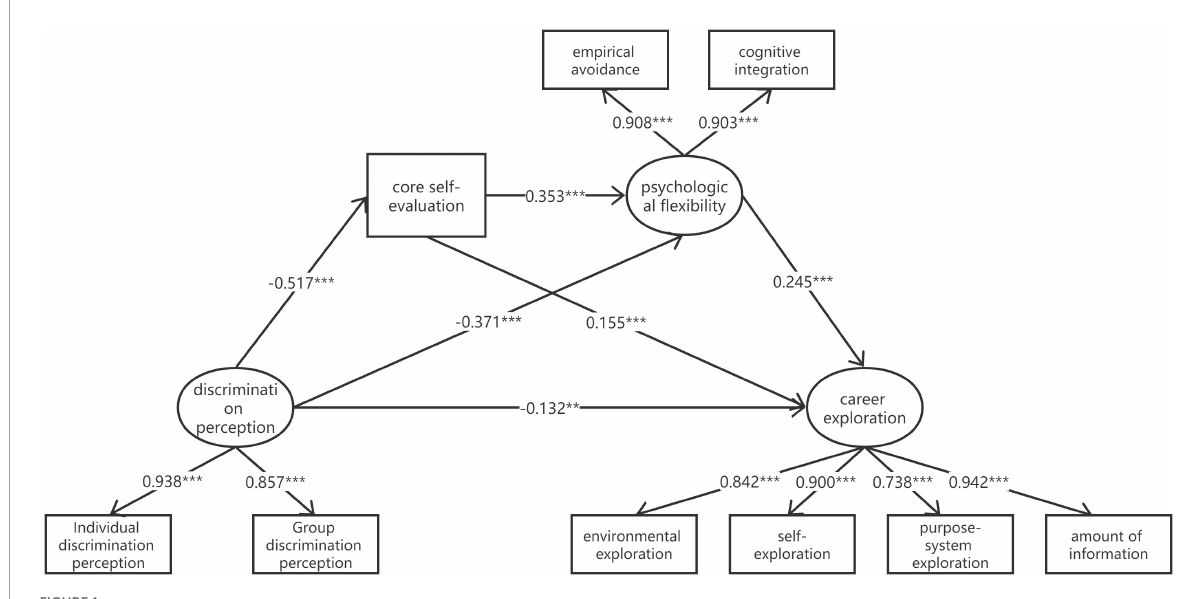
FIGURE1 The influence path of perceived discrimination on career exploration. ** p < 0.01, *** p < 0.001, N = 893.